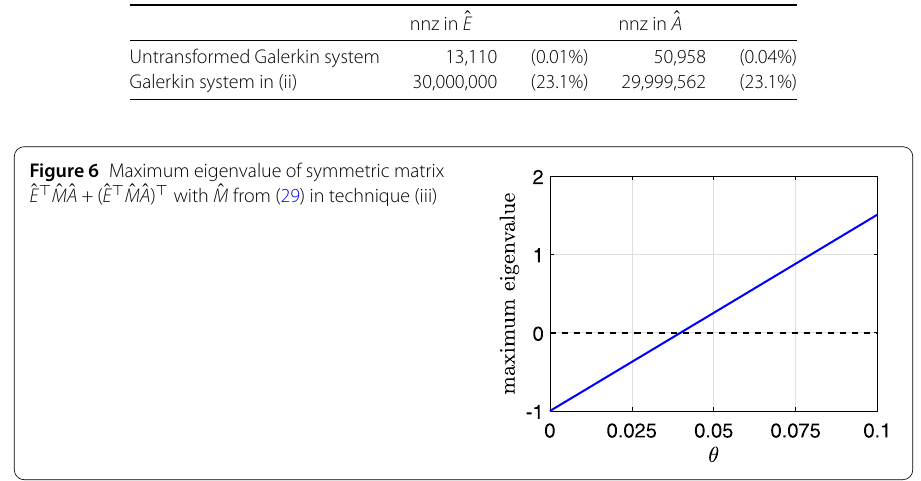
Table 3 Number of non-zero entries (nnz) in matrices of stochastic Galerkin systems for mass-spring-damper